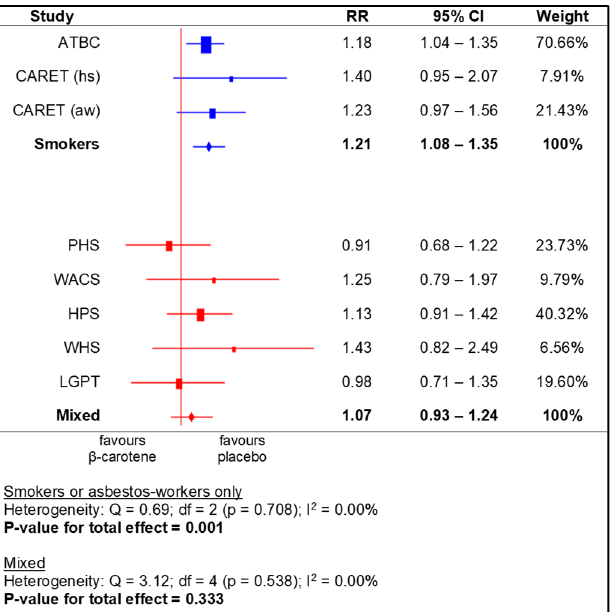
Figure 6. Meta-analysis for subgroups (smokers and asbestos-workers)—lung cancer incidence de-